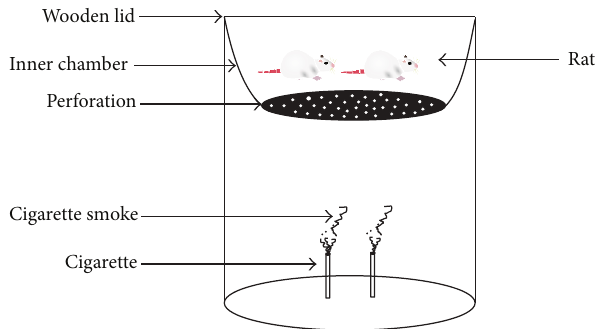
Figure 1: Inhalational chamber showing perforated inner chamber with wooden